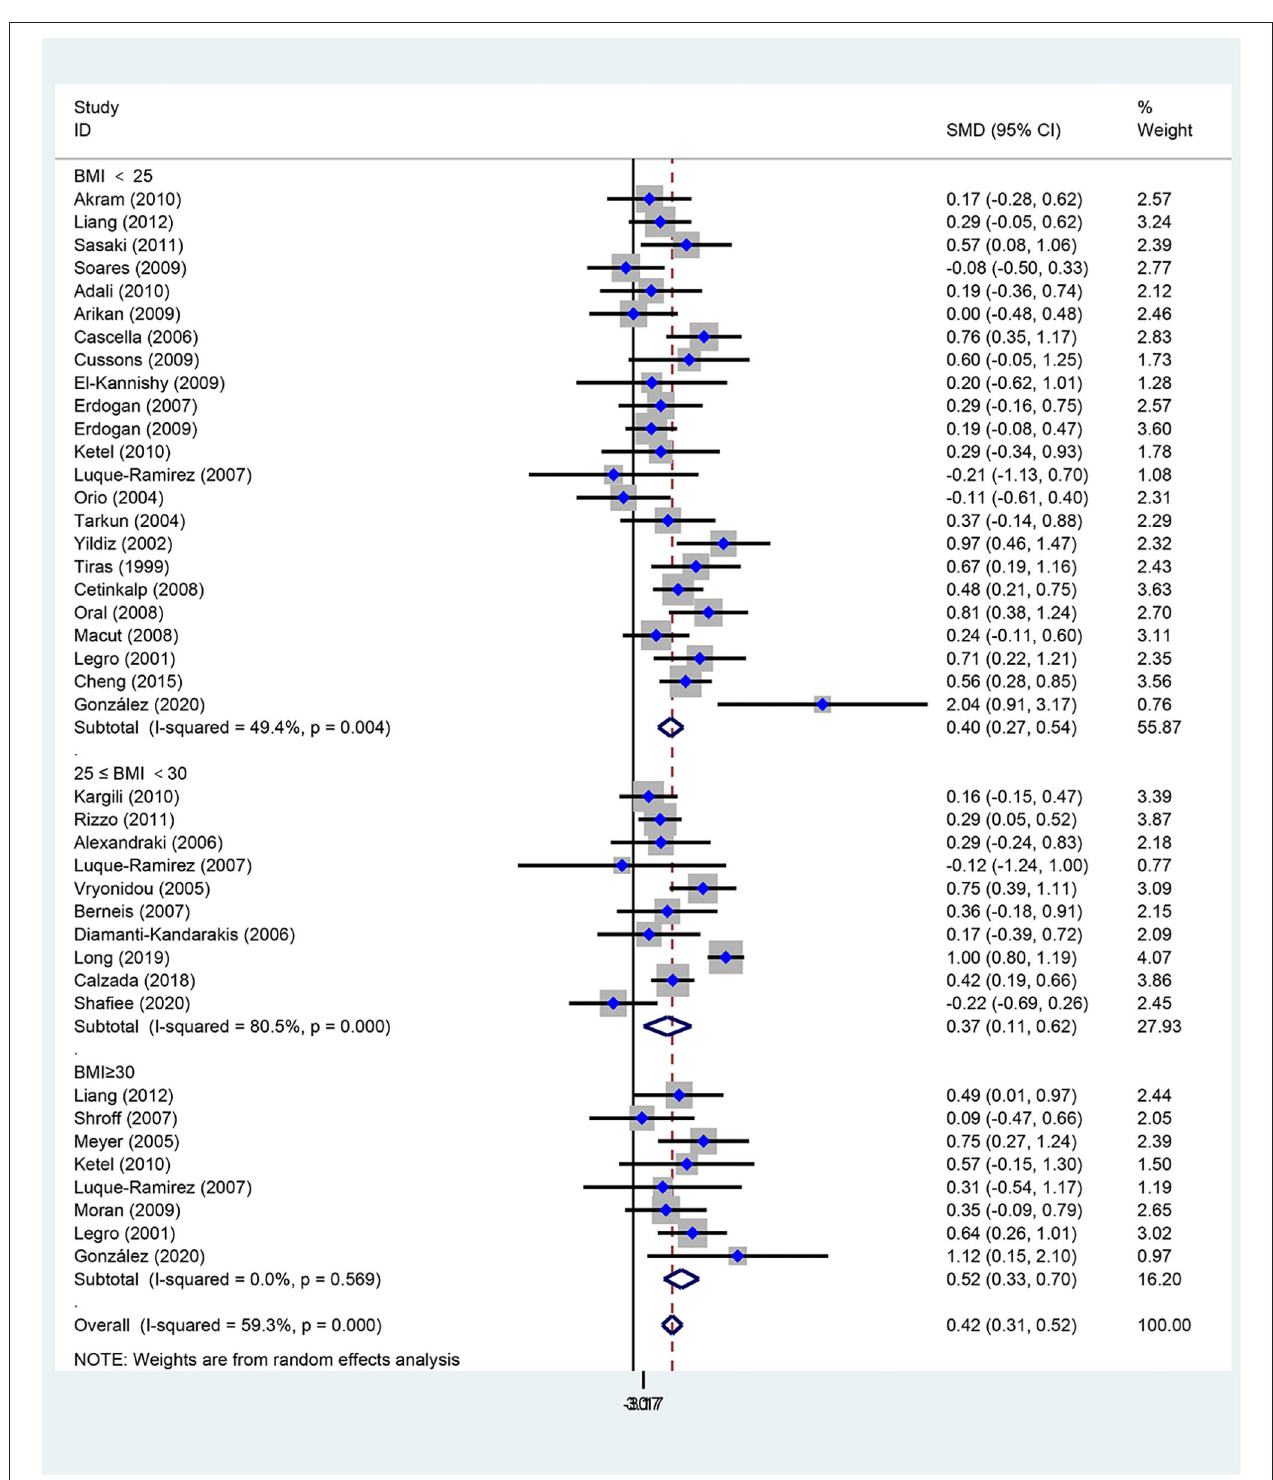
FIGURE 4 | Forest plot for comparison of non-high-density lipoprotein-cholesterol in polycystic ovary syndrome vs. control subjects. Studies are classified by different body mass index (BMI) categories (BMI < 25 kg/m 2 , BMI ≥ 30 kg/m 2 , and BMI 25–30 kg/m 2 ).